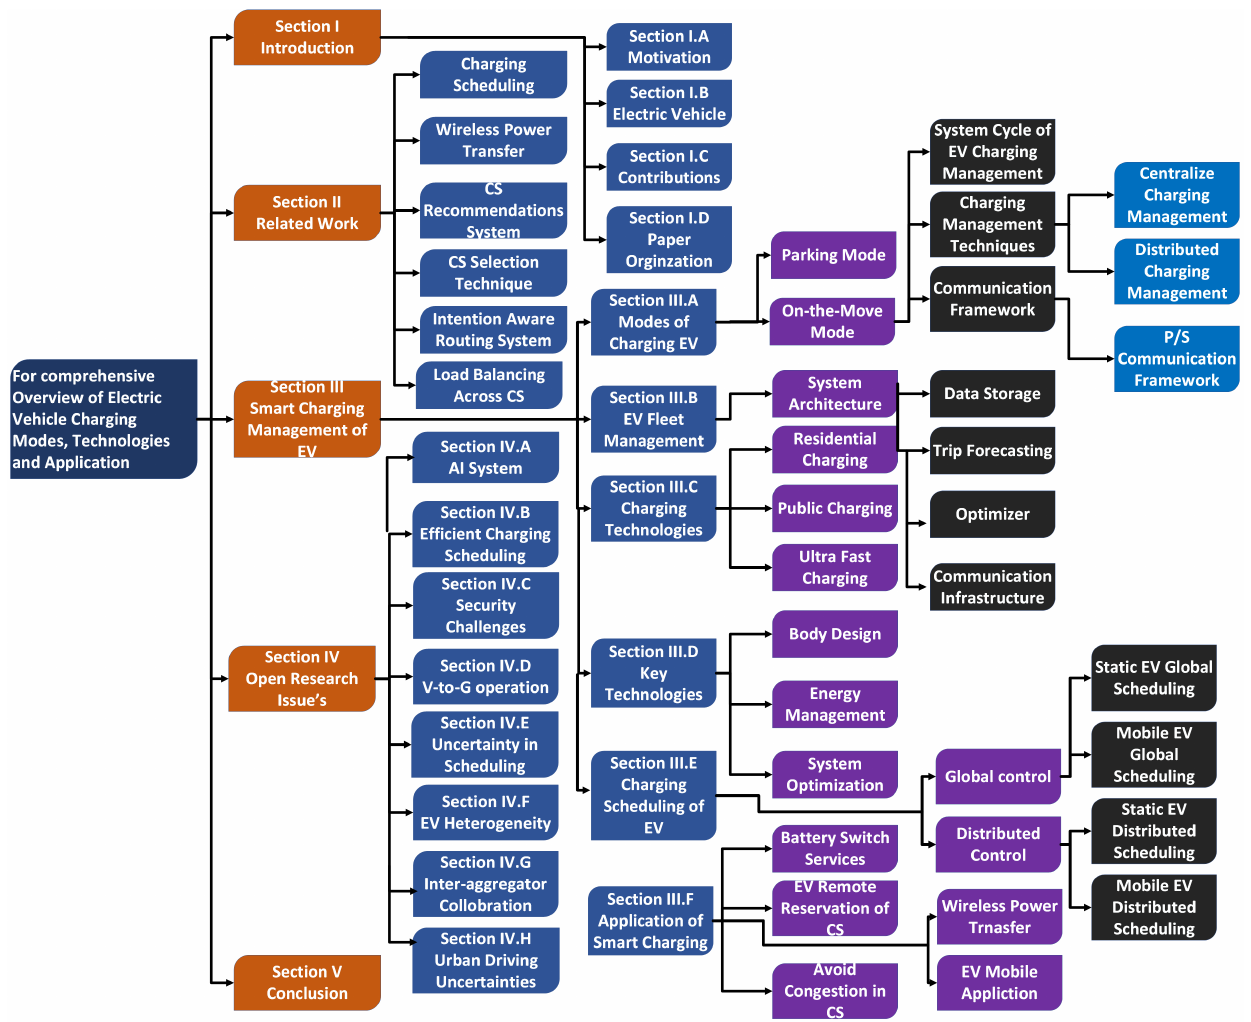
Figure 1. Organization of the Survey